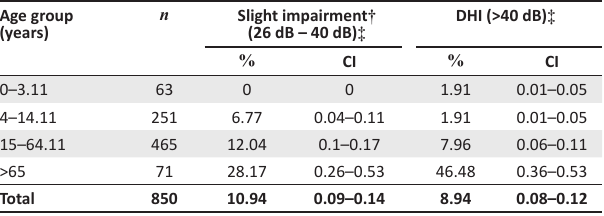
TABLE 3: Proportion of participants with hearing impairment ( % ) per age group ( n = 850).